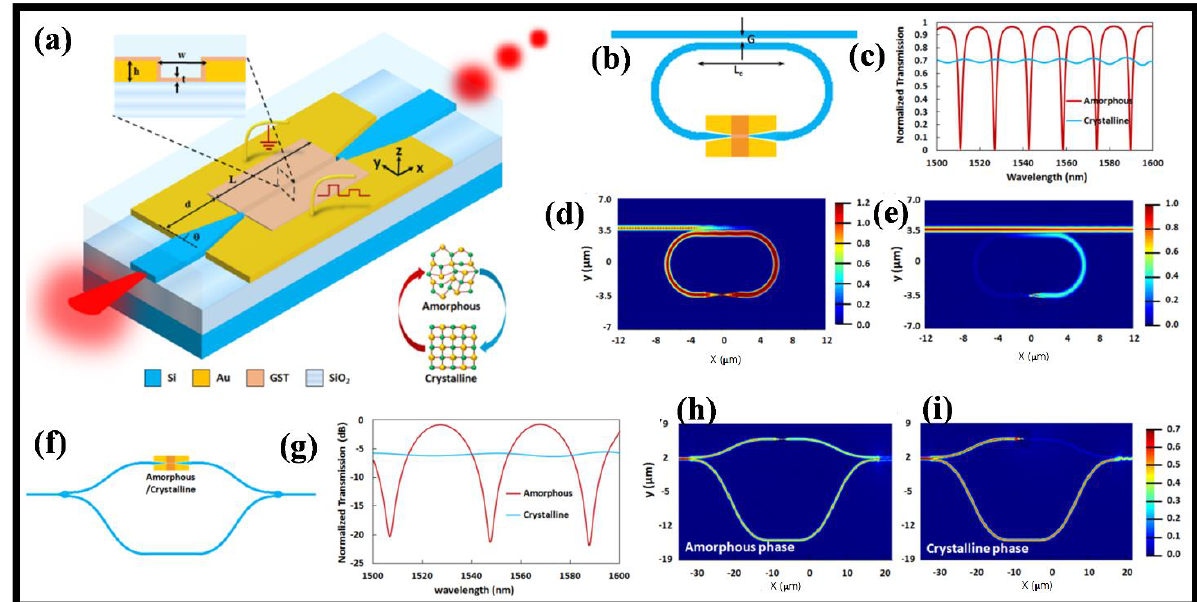
Figure 3. ( a ) The broadband NV hybrid EO plasmonic switch is shown schematically. The side view picture of the plasmonic slot WG with a thin coating of GST is shown in the inset [96], ( b ) The hybrid NV EO-plasmonic switch serves as the central unit in the racetrack µ -RR-based EO switch [96], ( c ) Normalized transmission spectra for the amorphous and crystalline phases of the PCM layer of the racetrack µ -RR-based EO switch, ( d , e ) The E-field mapping of the EO switch for the amorphous phase and the crystalline phase of the PCM layer at the resonance wavelength of 1558 nm, respectively [96], ( f ) Asymmetric MZI-based EO switch with hybrid NV EO plasmonic switch as an active component in one arm, ( g ) Normalized transmission band for the crystalline and amorphous phases of the PCM layer in the plasmonic switch for the asymmetric MZI based EO switch. The E-field distribution of the EO switch for the ( h ) amorphous phase and ( i ) crystalline phase of the PCM layer at the resonance wavelength of 1548 nm [96].